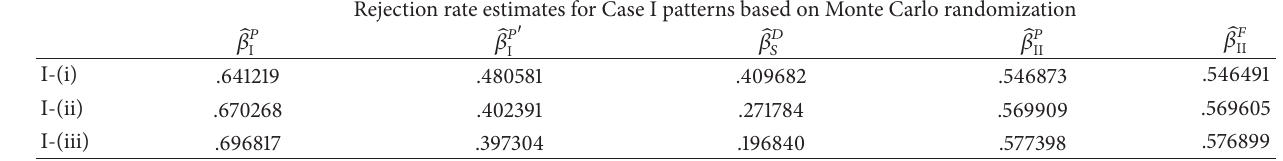
Table 6: Presented are the means ( ± SD (standard deviations)) of the off-diagonal entries, 𝑁 12 , 𝑁 21 , and their difference 𝑁 12 − 𝑁 21 and the rejection rate estimates under Case I patterns in (33) with 𝑁 Monte Carlo randomization with 𝑛 1 = 𝑛 2 = 40 and 1000 Monte Carlo randomization steps are performed for each of 𝑁 samples under Case I patterns (b). approximation with and without Yates’ continuity correction, respectively; symmetry test conditional on 𝑁 12 + 𝑁 21 = 𝑛 𝑡 ; for the exact test on the 𝑄 -symmetry contingency table.